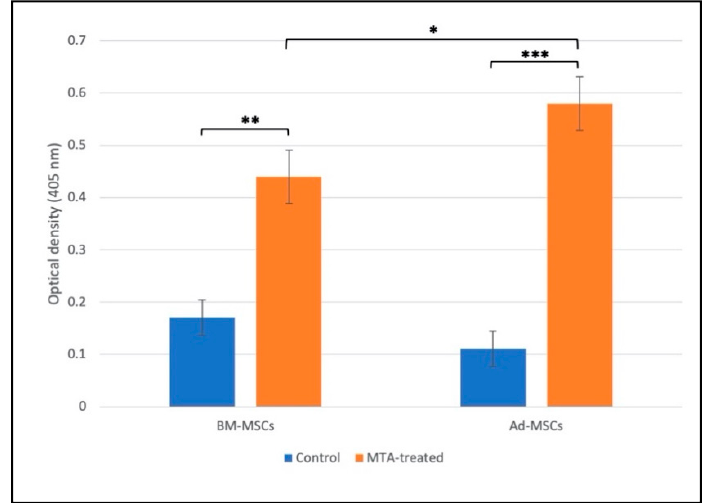
Figure 5. Alizarin red S (ARS) acid extraction to semiquantify the production of mineral deposits. After 14 days of incubation in 0.2 mg/mL MTA-conditioned media, Ad/BM-MSCs exhibited significantly higher amounts of absorbed dye than control groups. Furthermore, semiquantitative analysis of ARS staining revealed that the Ad-MSCs treated with MTA-conditioned medium produced significantly more stained mineral deposits than BM-MSCs. Values are mean ± SD, n = 6; *, **, and *** indicate p values less than 0.05, 0.01, and 0.001, respectively.